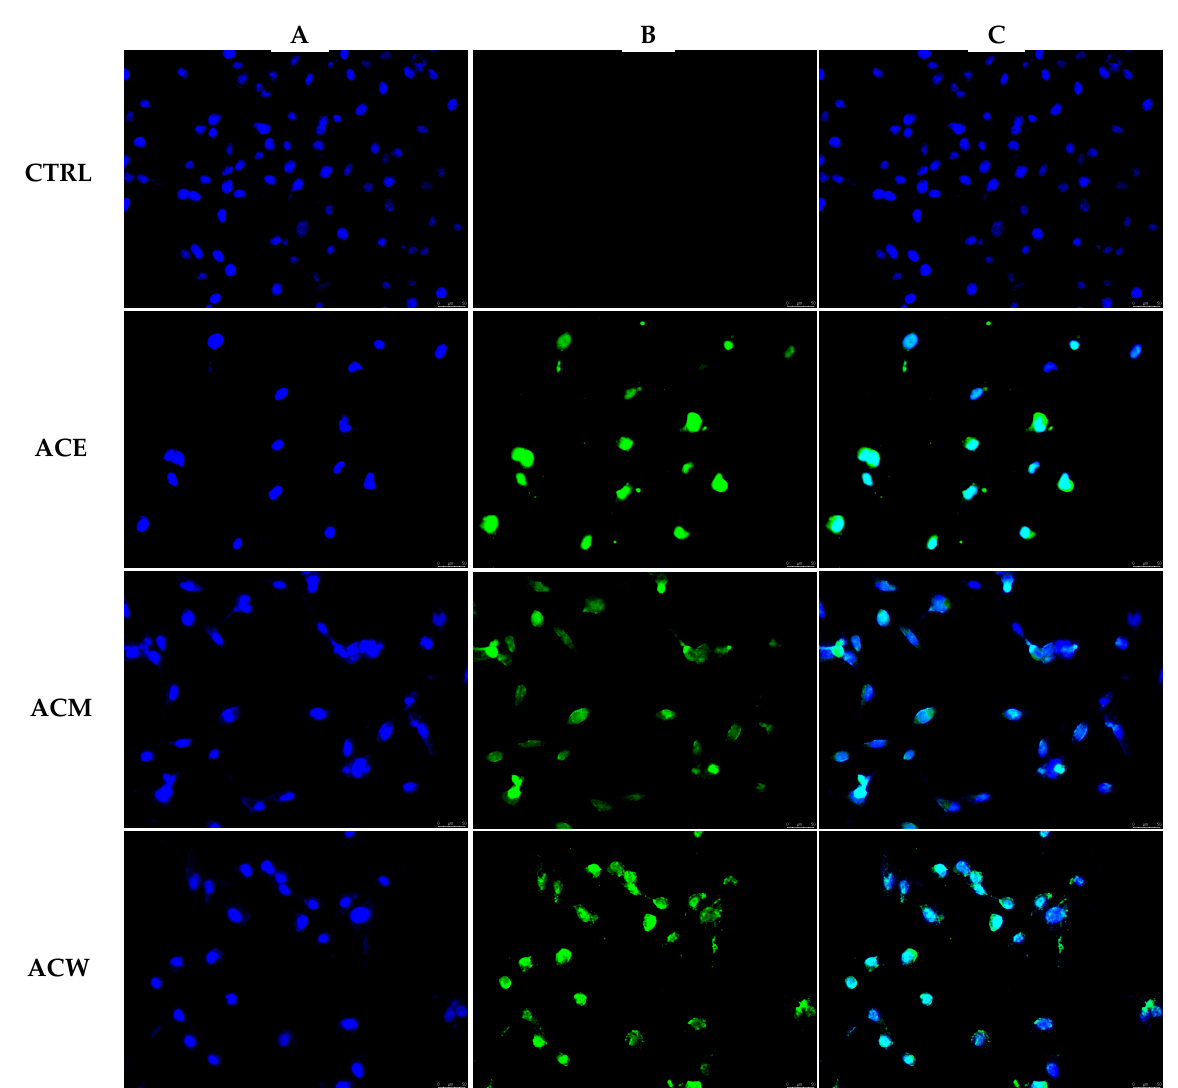
Figure 3. Apoptosis detection by TUNEL assay on A2058 cells treated with ethanolic, methanolic and aqueous A. cherimola Mill. leaf extracts (ACE, ACM and ACW) at their IC 50 values or with vehicle (DMSO, CTRL) for 24 h. Cells were then subjected to the TUNEL procedure (as reported in Materials and Methods) and imaged under an inverted fluorescence microscope at 20 × magnification. ( A ) DAPI ( λ ex/em = 350/460 nm); ( B ) CF TM 488A ( λ ex/em = 490/515 nm); ( C ) overlay channel. Images are representative fields of three independent experiments.